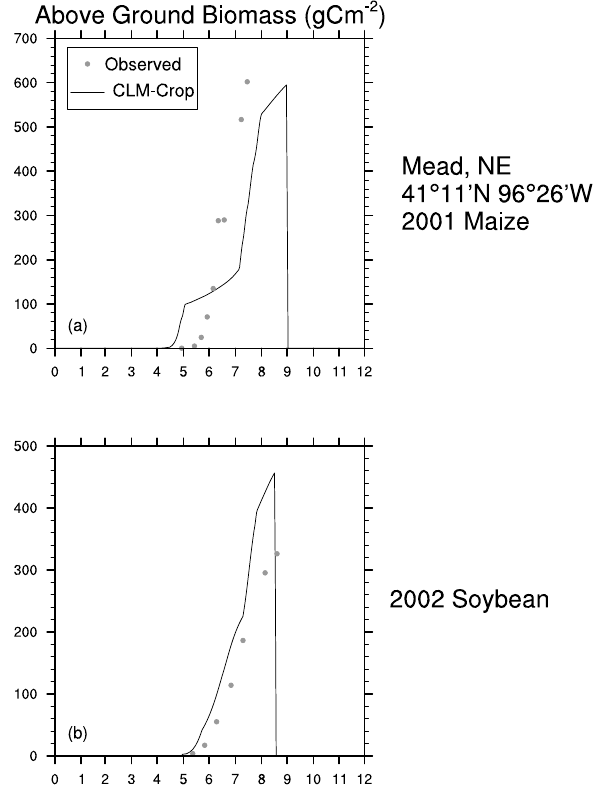
Fig. 5. Simulated (lines) and observed (circles) total plant carbon (g C m − 2 ) during 2001 and 2002 for maize and soybean at Mead, NE.